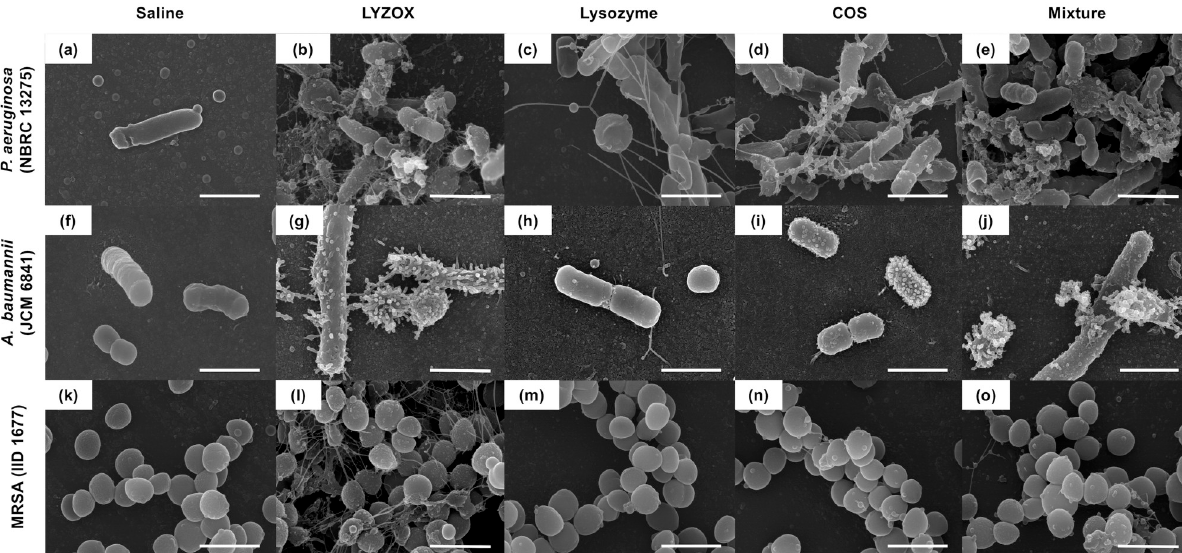
Fig 7. Scanning electron microscopic findings in Pseudomonas aeruginosa , Acinetobacter baumannii and methicillin-resistant Staphylococcus aureus . Scanning electron micrographs of Pseudomonas aeruginosa (NBRC 13275) (a, b, c, d, e), Acinetobacter baumannii (JCM 6841) (f, g, h, i, j) and MRSA (IID 1677) (k, l, m, n, o) incubated with each treatment for 2 h. (a), (f) and (k) were not treated (control). (b), (g) and (l) were treated with lysozyme-chitosan oligosaccharide conjugate (LYZOX, 1,000 μ g/mL). (c), (h) and (m) were treated with lysozyme (500 μ g/mL). (d), (i) and (n) were treated with chitosan oligosaccharide (COS, 500 μ g/mL). (e), (j) and (o) were treated with the mixture (lysozyme [500 μ g/mL] and COS [500 μ g/mL]). Bacteria were photographed at a magnification of × 20,000. Scale bar = 1.5 μ